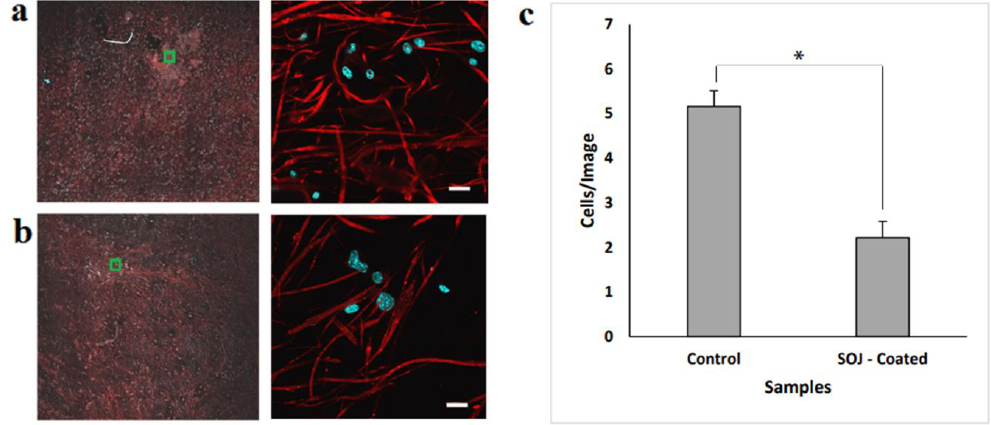
Figure 4. Cell adhesion and proliferation for PHB samples after 7 days. The figure shows map images (left) of PHB samples along with higher-magnification images (right) taken from the area within the green squares. ( a ) PHB mats as control samples; and ( b ) SOJ-coated PHB fiber mats. Cell nuclei were labeled with 4’, 6-diamino-2-phenylindole (DAPI) (blue), with MitoTracker Red labeling both mitochondria and PHB fibers (scale bar = 20 μ m). ( c ) Comparison between the numbers of cells in the control and SOJ-coated PHB fiber membranes based on 6 images per sample (* p -value < 0.05).